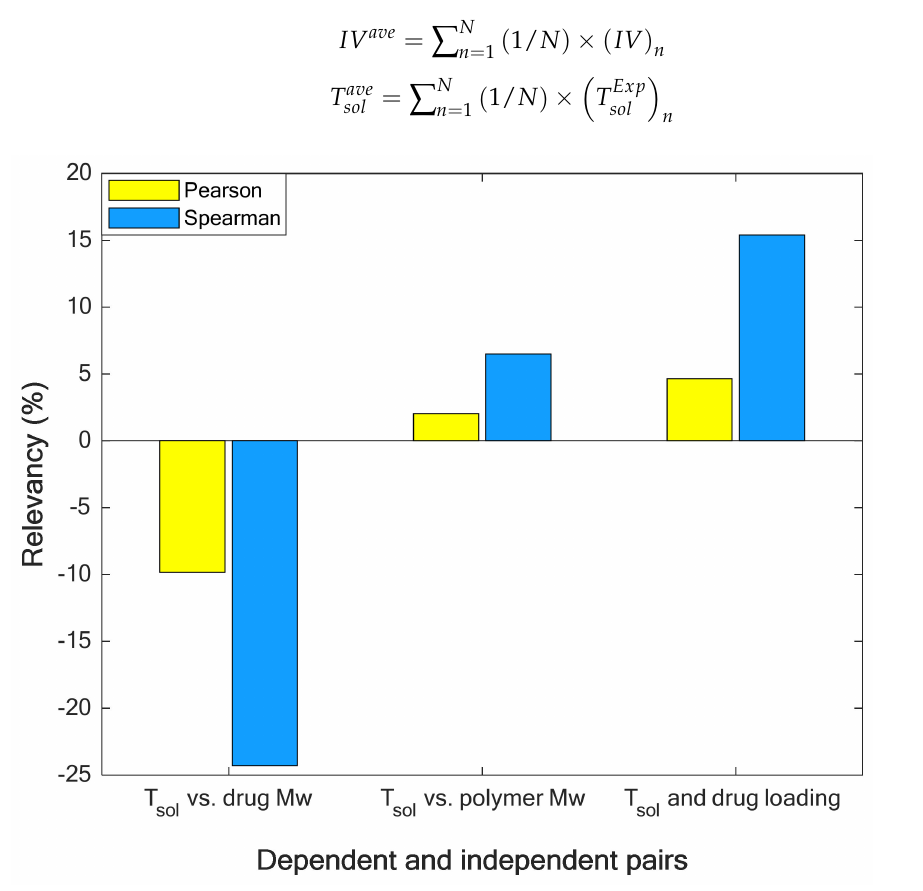
Figure 1. Quantizing the relevancy (strength and direction of relationship) between solubility temperature and its affecting